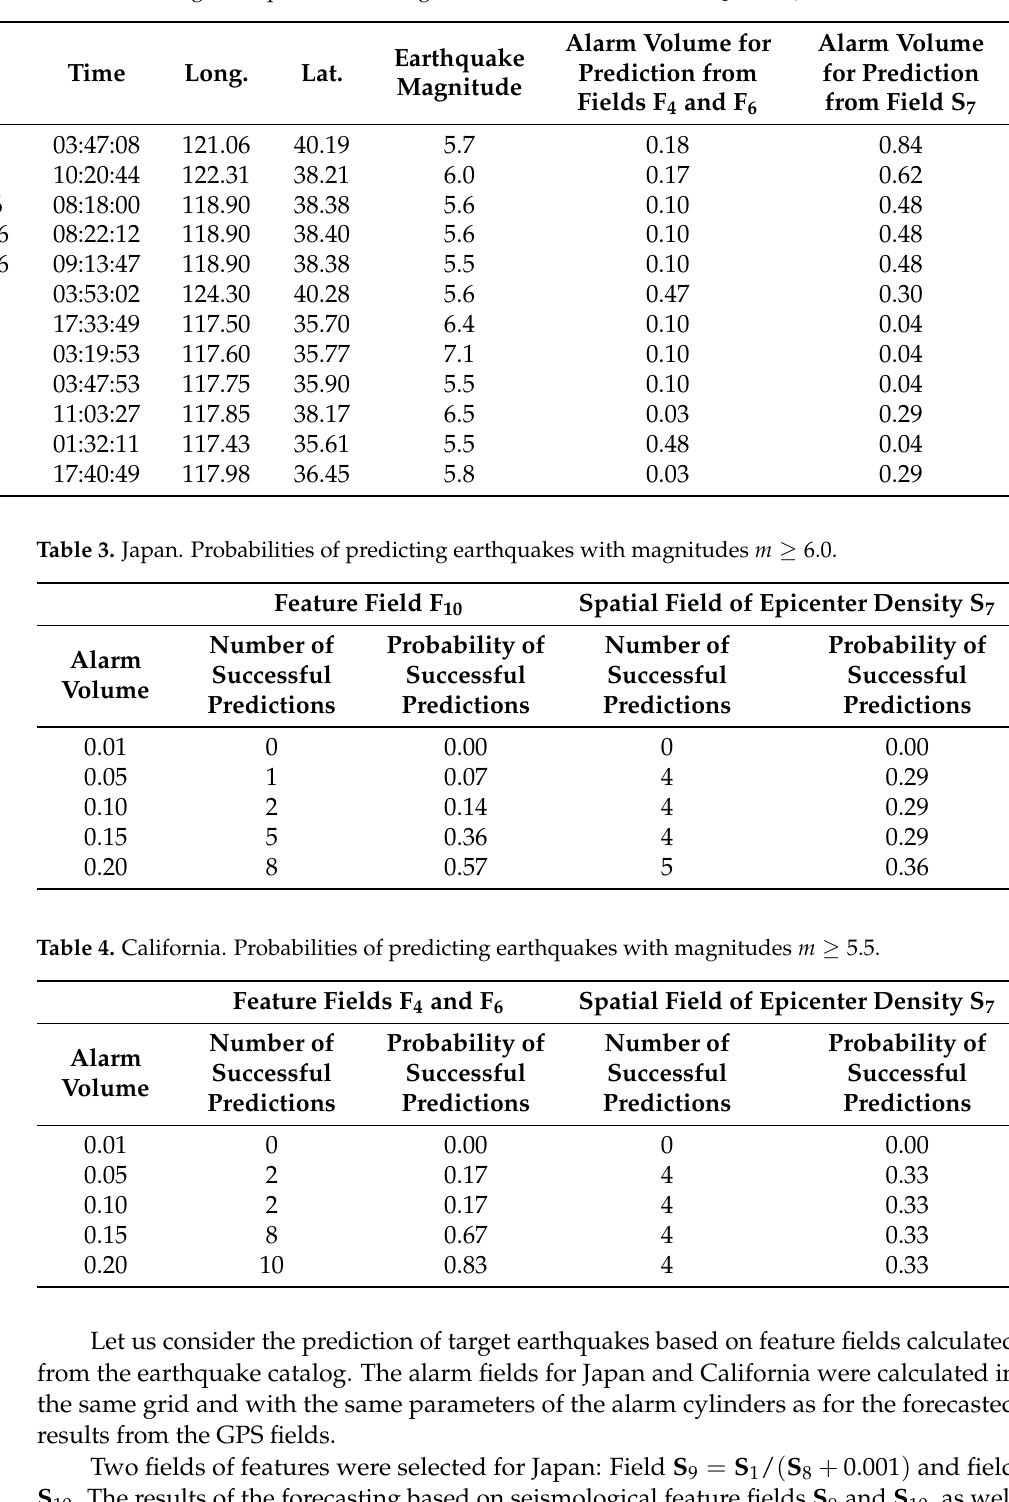
Table 2. California. Results of forecasting earthquakes with magnitudes m ≥ 5.5 from fields F 4 and F 6 and field S 7 .